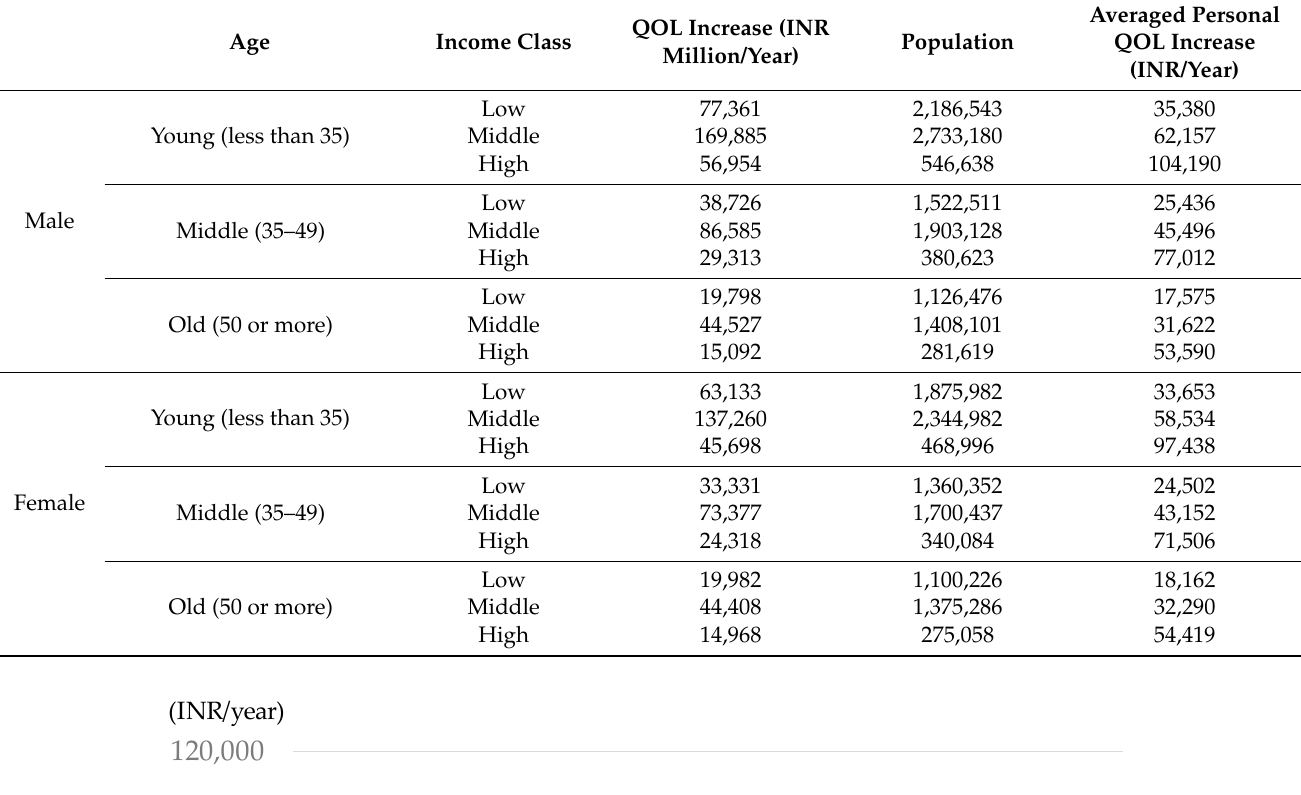
Table 10. Summary of estimated QOL impacts by personal attributes.